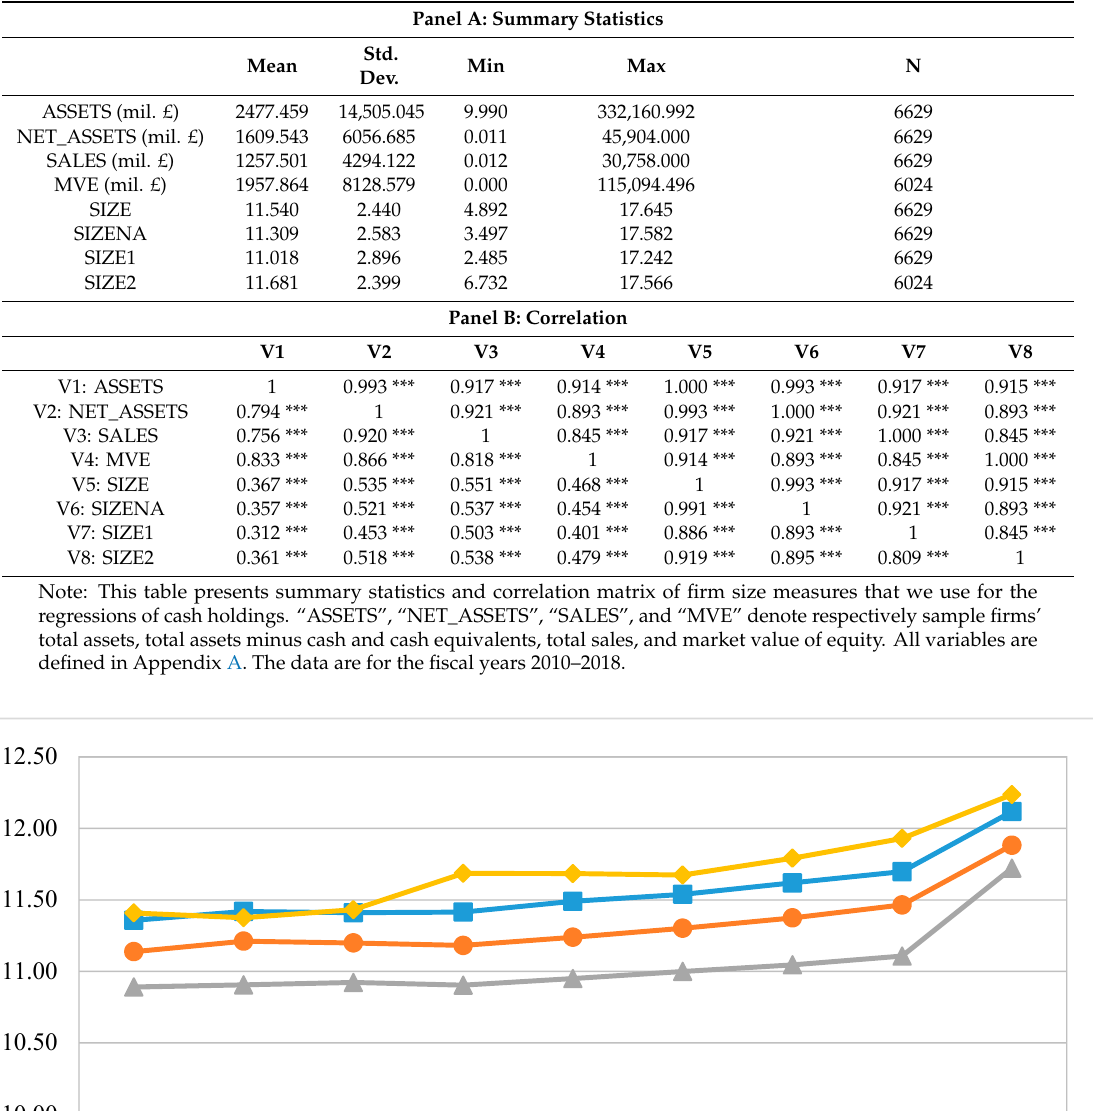
Table A2. Firm Size Measures for Firm’s Cash Holdings Regression.